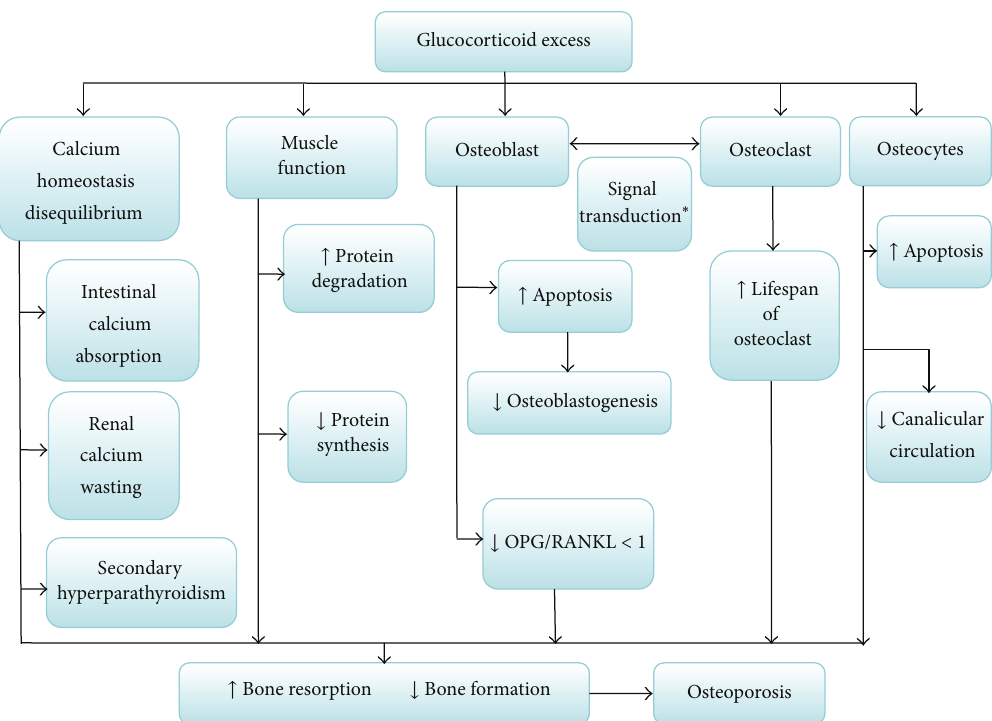
Figure 1: Effect of glucocorticoid excess on bone after transplantation. The atlas has indicated that glucocorticoid has direct and indirect pathway to mediate osteoporosis and inhibits bone formation after transplantation. The signal transduction pathway ∗ : some factors establish a bridge between osteoblast and osteoclast, like complement component 3a (C3a) and collagen triple helix repeat containing 1 (Cthrc1), but there are few literatures after organ transplantation. The upward arrows show promoting effect; the downward arrows show lessening or inhibitory